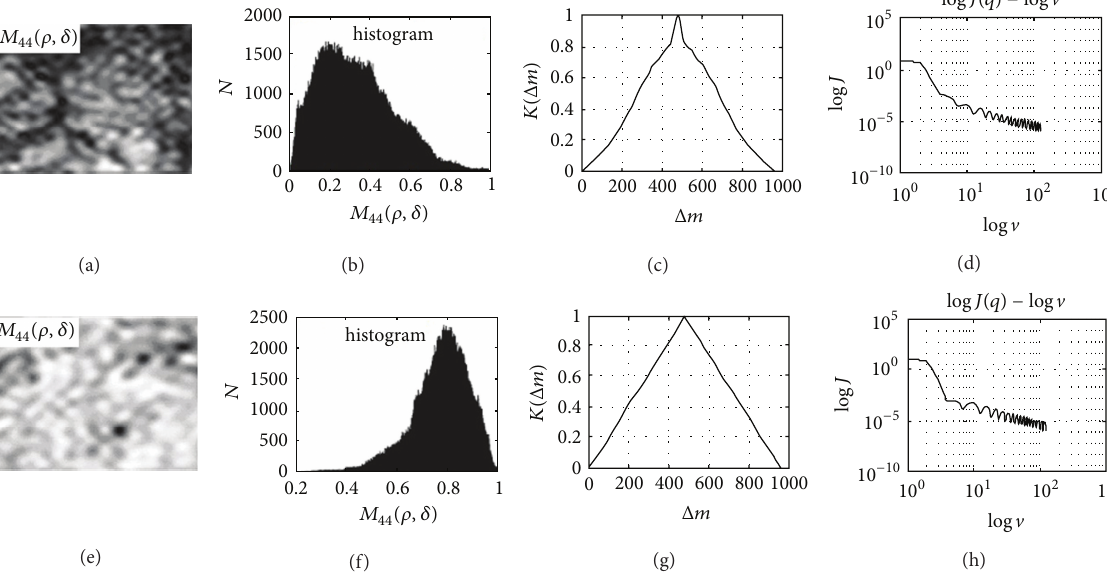
Figure 3: “Low-frequency” coordinate maps 𝑀 44 (𝜌,𝛿) (a), (e) histograms (b), (f) autocorrelation functions (c), (g) logarithmic dependence of the power spectra (d), (h) of the linear birefringence distribution of a histological section of benign uterine tumor (fibromyoma) biopsy ((a)–(d)), and malignant uterine tumor (adenocarcinoma) biopsy ((e)–(h)).